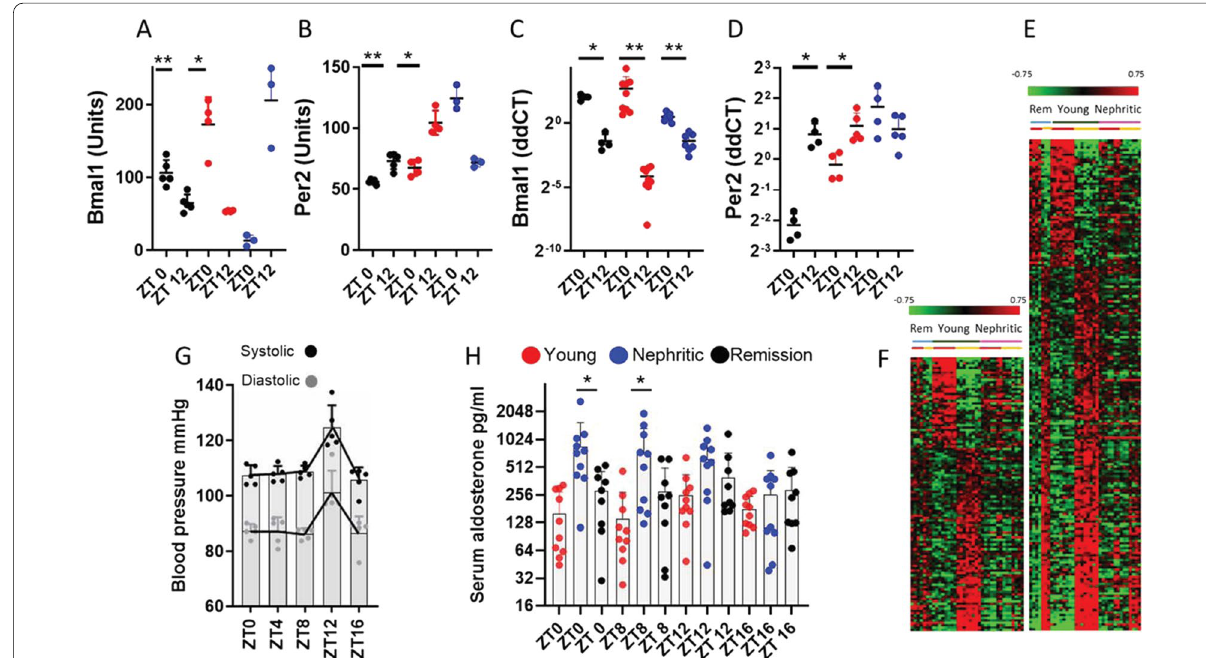
Fig. 5 Partial correction of circadian dysfunction by remission induction therapy. A, B Bmal1 and Per2 protein expression measured in renal lysates by ELISA; C , D Bmal1 and Per2 expression measured in whole renal mRNA by qPCR; E , F Heatmap of 320 genes that differed between ZT0 (red bars) and ZT12 (Orange bars) in young but not nephritic kidneys showing correction of 205 genes ( E ) and failure to correct 115 genes ( F ). G Blood pressure in remission mice shows normalization of dipping pattern; H Correction of serum aldosterone in remission mice. * p < 0.05. Red symbols: young mice; Blue symbols: nephritic mice; Black symbols: remission mice—each symbol represents one